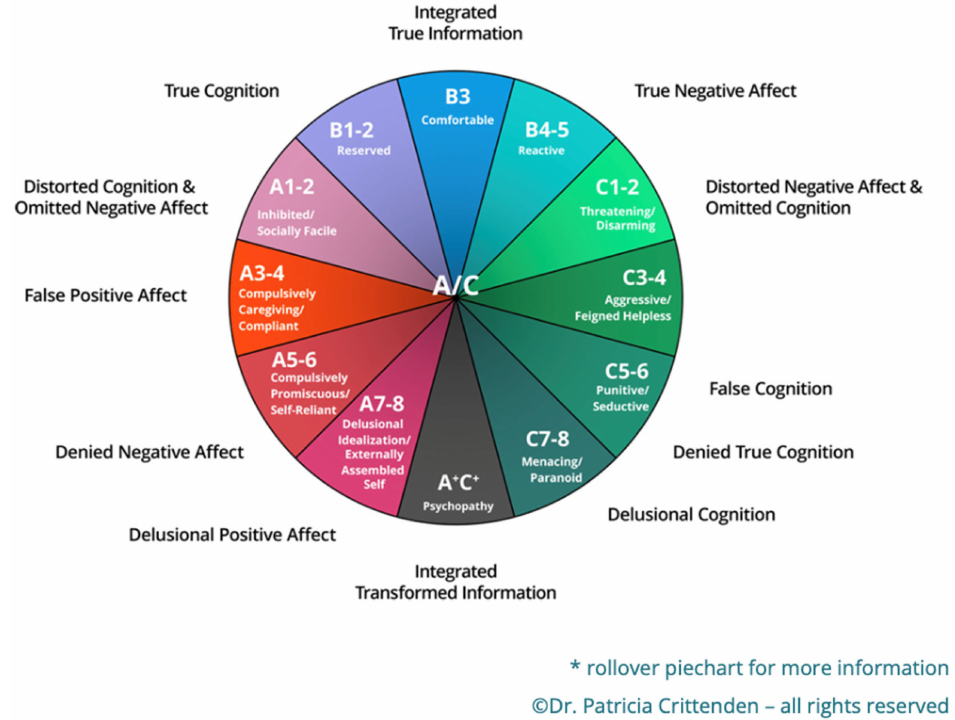
Figure 1. The DMM Model, www.familyrelationsinstitute.org (accessed on 15 June 2022). Permis- sion